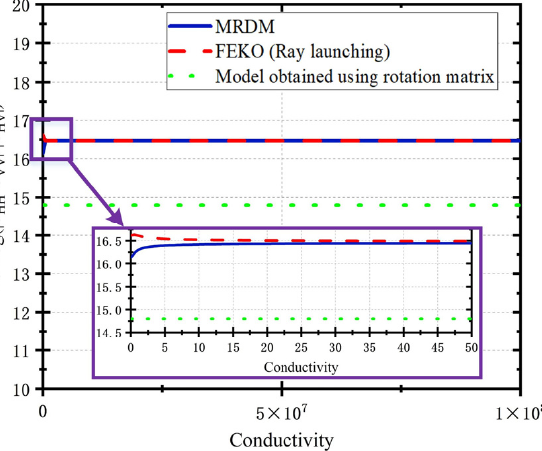
Figure 3. Comparison of parametric scattering model with different conductivities.